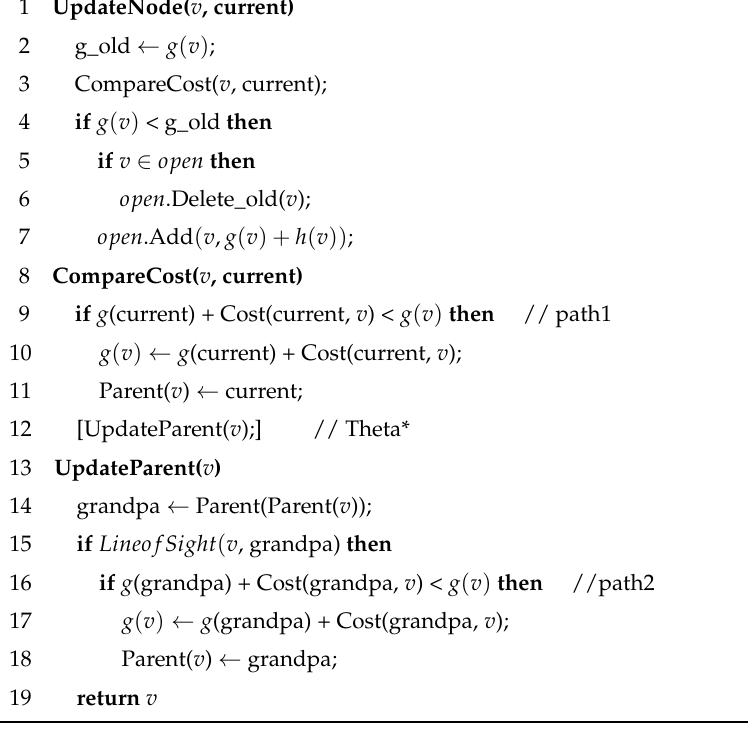
Algorithm 2 : Relative